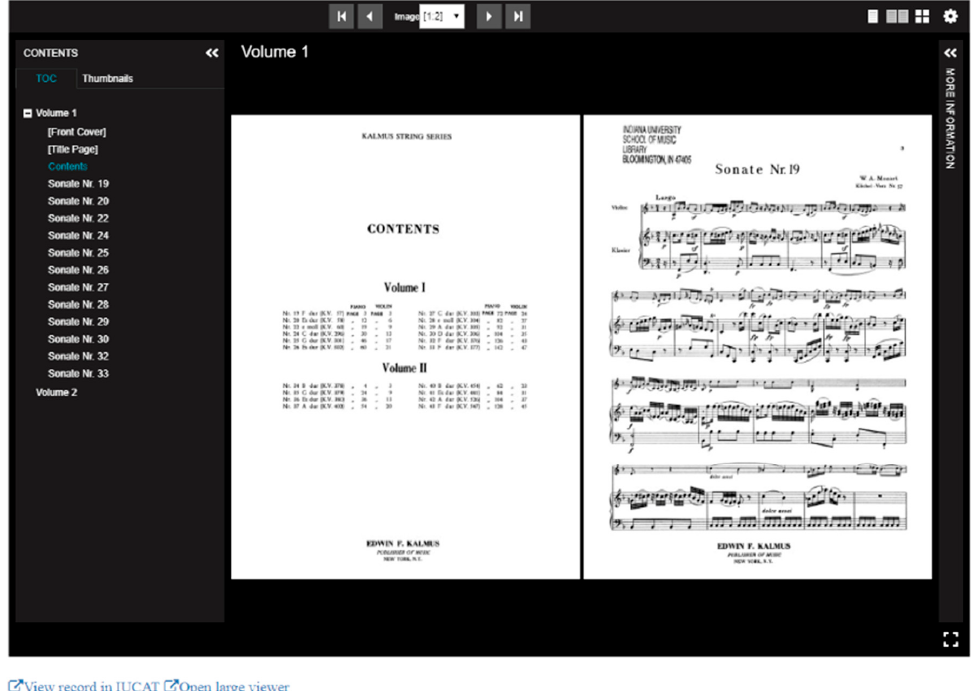
Figure 5. Item viewed in the Universal Viewer in Indiana University’s Pages